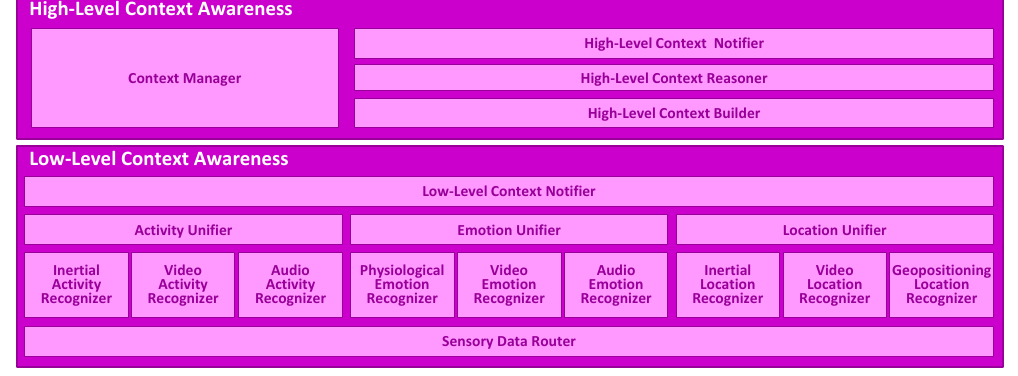
Figure 1. Architecture of the multimodal context mining framework.